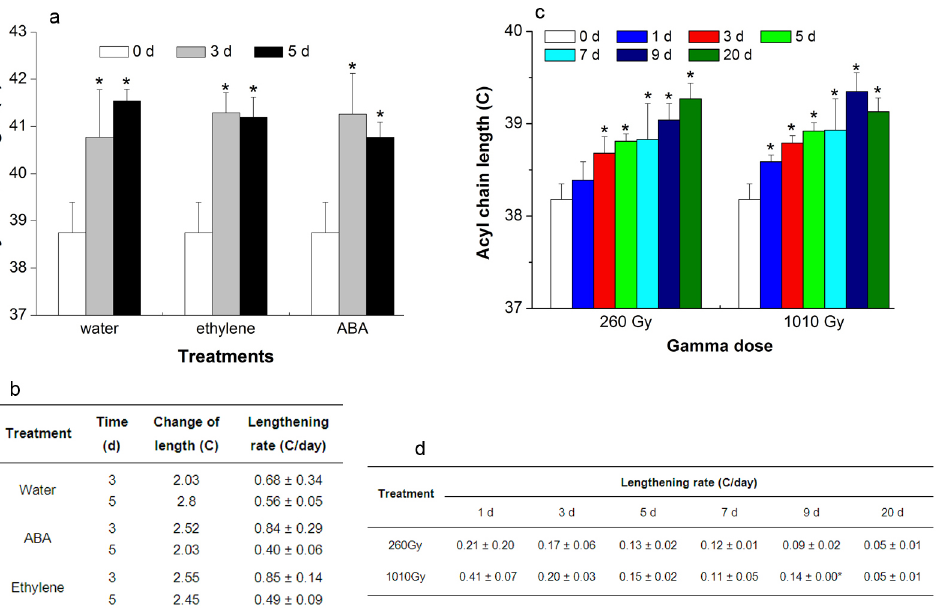
Figure 4. Acyl chains of PS lengthen with detachment-, ABA- and ethylene-induced senescence, and gamma irradiation in Arabidopsis . ( a ) The acyl chain length of PS treated with water, ABA, and ethylene in detached leaves, ( b ) The lengthening rate of PS treated with water, ABA, and ethylene in detached leaves, ( c ) The acyl chain length of PS in leaves at 0, 1, 3, 5, 7, 9, and 20 d after irradiation, ( d ) The lengthening rate of PS in leaves after irradiation. Values are means 6 s.d. ( n =5). An asterisk indicates that the value is different from that of control or that of 260 Gy at same time ( p , 0.05 ).